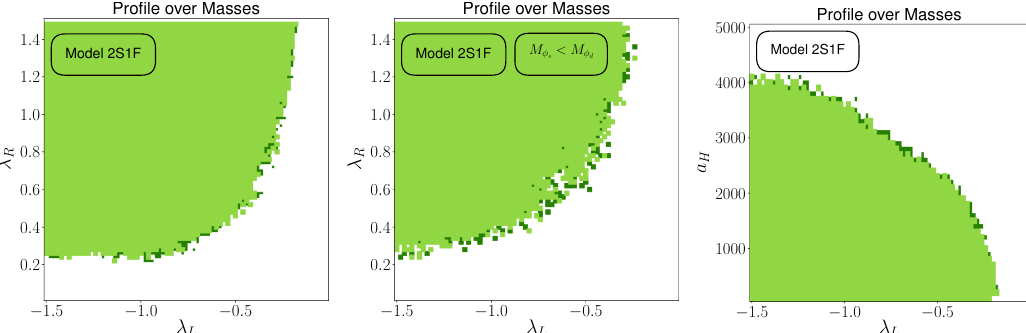
Figure 11. Profile over the λ L − λ R plane or the λ L − a H plane for Model 2S1F, scanning over the masses of the new scalars and fermion between 0 and 5000 GeV, as well as the mixing a and coupling λ [0 , 1 . 5] . Colours are the same as in figure 9. The scan targeted the observed R ∈ value of the dark matter relic density 0 . 1200 , eq. (1.8), the value of ∆ a detection log likelihood provided by DDCalc [508, 509], where points which are excluded by direct detection or are more than 3 σ away from the Planck observation are thrown